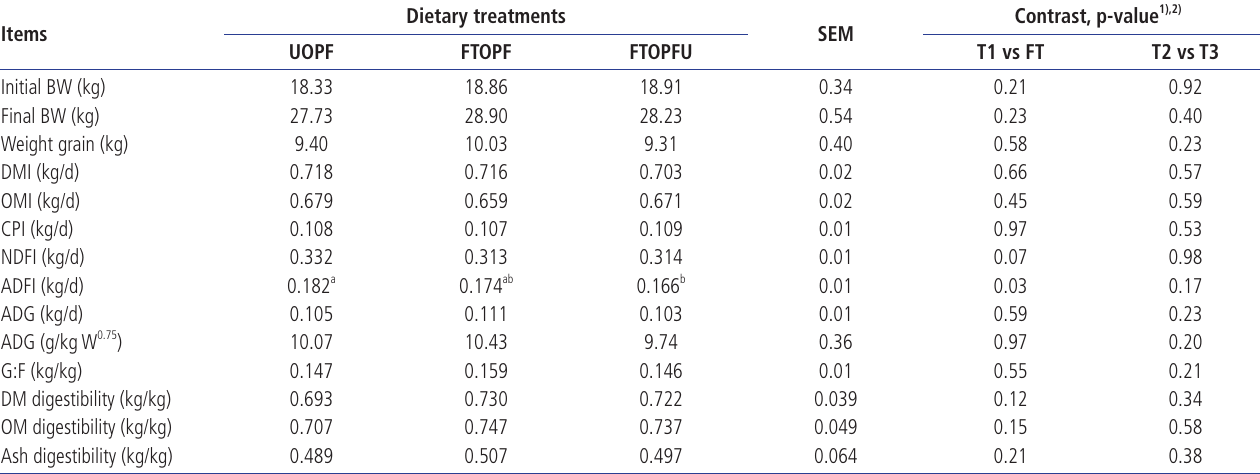
Table 2. Effects of diet on performance and DMI of finishing